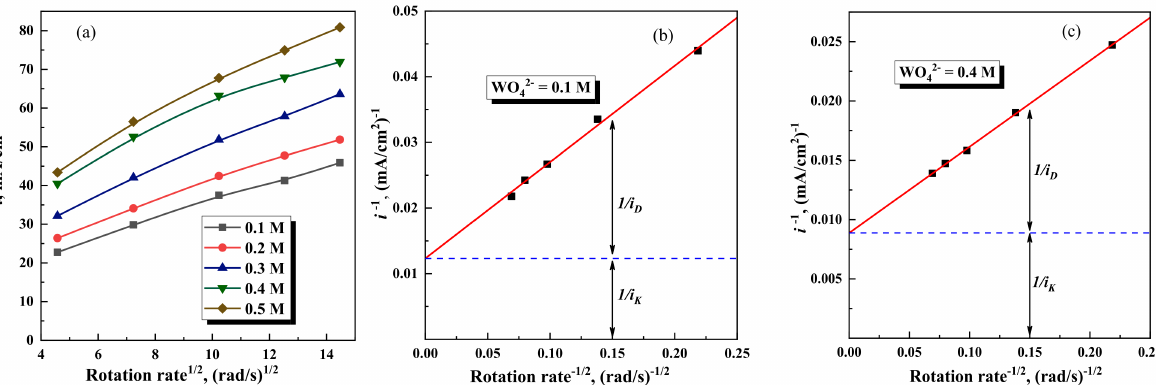
Figure 6. Levich plots were obtained for various concentrations of Na 2 WO 4 ( a ), and Koutecky-Levich plots for indicated concentrations of Na 2 WO 4 ( b , c ). All presented data were obtained at E = − 1.05